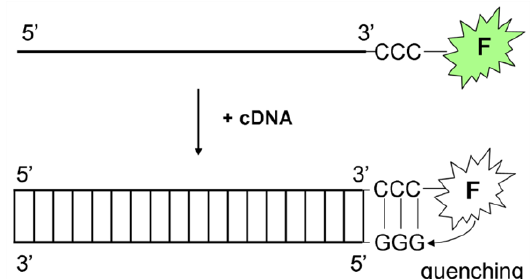
Figure 2. Schematic representation of FAM–DNA quenching due to photoinduced electron transfer (PET) upon hybridization with a guanine-containing complementary oligo cDNA target.